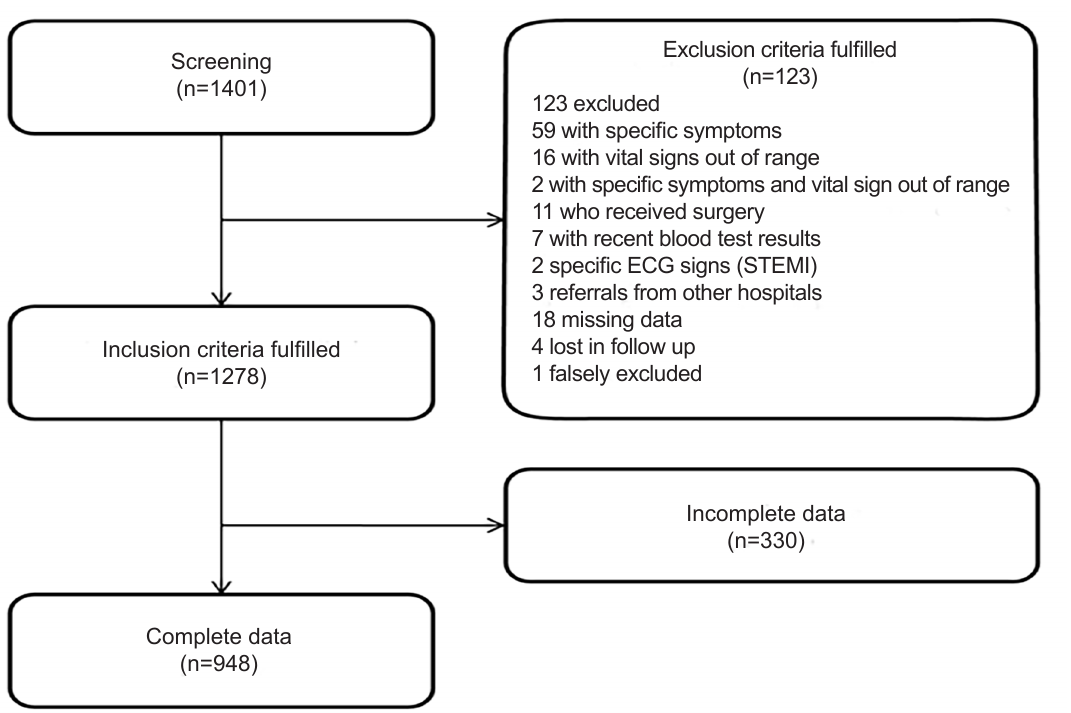
Figure 1. Patient enrollment chart. ECG , electrocardiogram; STEMI ; ST-elevation myocardial